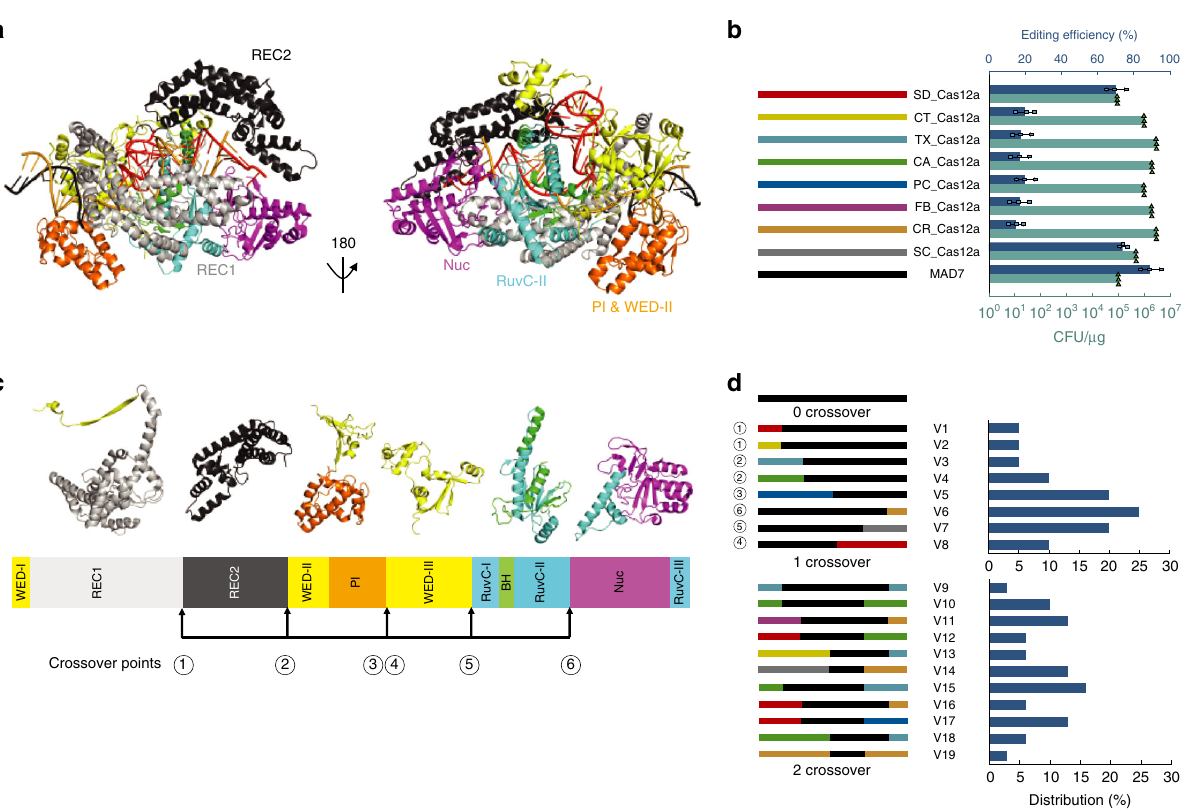
Fig. 1 Cas12a-type chimera library construction. a The Cas12a-like protein structure analysis based on AsCas12a (PDB:5B43). b The editing and transformation ef fi ciencies of the Cas12a-like nucleases used in this study. The Cas12a-like nucleases, used in this study, are SD_Cas12a ( Succinivibrio dextrinosolvens ), CT_Cas12a ( Candidatus Methanoplasma termitum ), TX_Cas12a ( Thiomicrospira sp . XS5), CA_Cas12a ( Candidatus Methanomethylophilus alvus ), PC_Cas12a ( Porphyromonas crevioricanis ), FB_Cas12a ( Flavobacterium branchiophilum ), CR_Cas12a ( Candidatus Roizmanbacteria bacterium GW2011_GWA2_37_7), SC_Cas12a (synthetic construct of AsCas12a), and MAD7. The editing ef fi ciency, as determined by galK inactivation assay, was shown in blue, and the transformation ef fi ciency was shown in green. c The domains were separated by the six crossover points, which were WED-I&REC1, REC2, WED-II&PI, WED-III, RuvC-1&BH&RUVC-II, and Nuc&RuvC-III. d The distribution of the chimera library variants. Cas12a-type libraries were made as described in the online methods. The numbers to the left of variants were the crossover points shown in ( c ). The swapped regions are shown by different colors; the colors are the same as in ( b ). Source Data are available in the Source Data